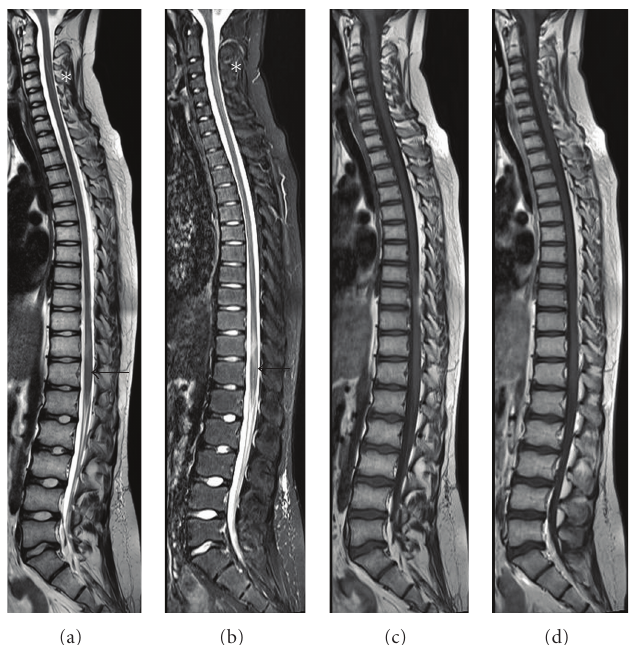
Figure 3: Whole cord MR images 6 weeks after the first MRI. Sagittal T2WI (a) and STIR-T2WI (b) show resolution of the cervical lesion (white asterisks), whereas a slight hyperintensity is seen in the lumbar cord (black arrows). There are no abnormalities on sagittal T1WI without (c) and with intravenous gadolinium